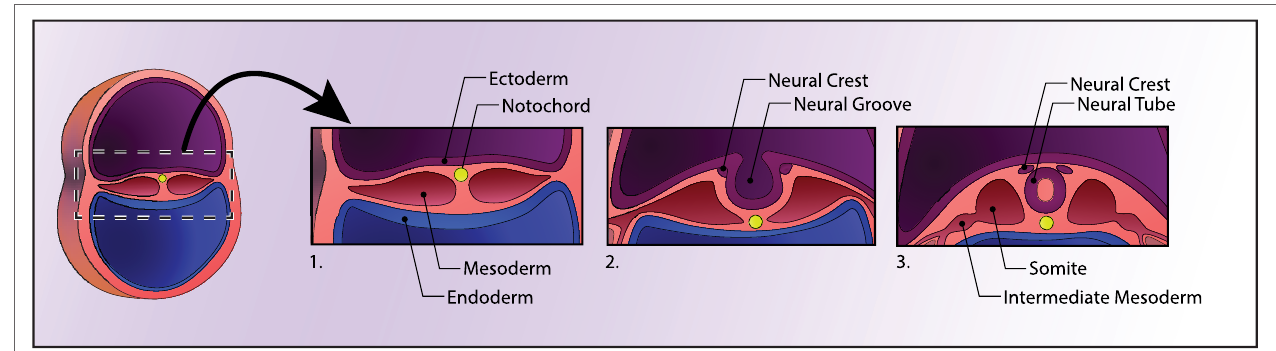
FigURe 1 | Human neural development. A cross section of the early embryo is depicted on the left. In the first panel, the three germ layers and the notochord are shown. The notochord signals the ectoderm above it to form the neural plate, which then folds into itself to form the neural tube, depicted in panel 3. See Box 1 for